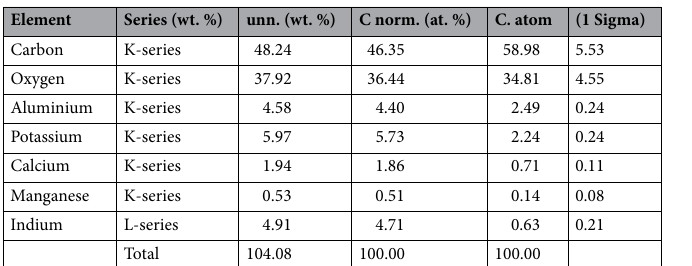
Table 1. The elemental composition of